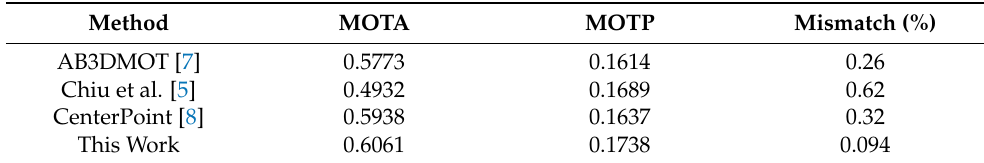
Table 7. Comparison on Waymo Open Dataset test set, vehicle class.